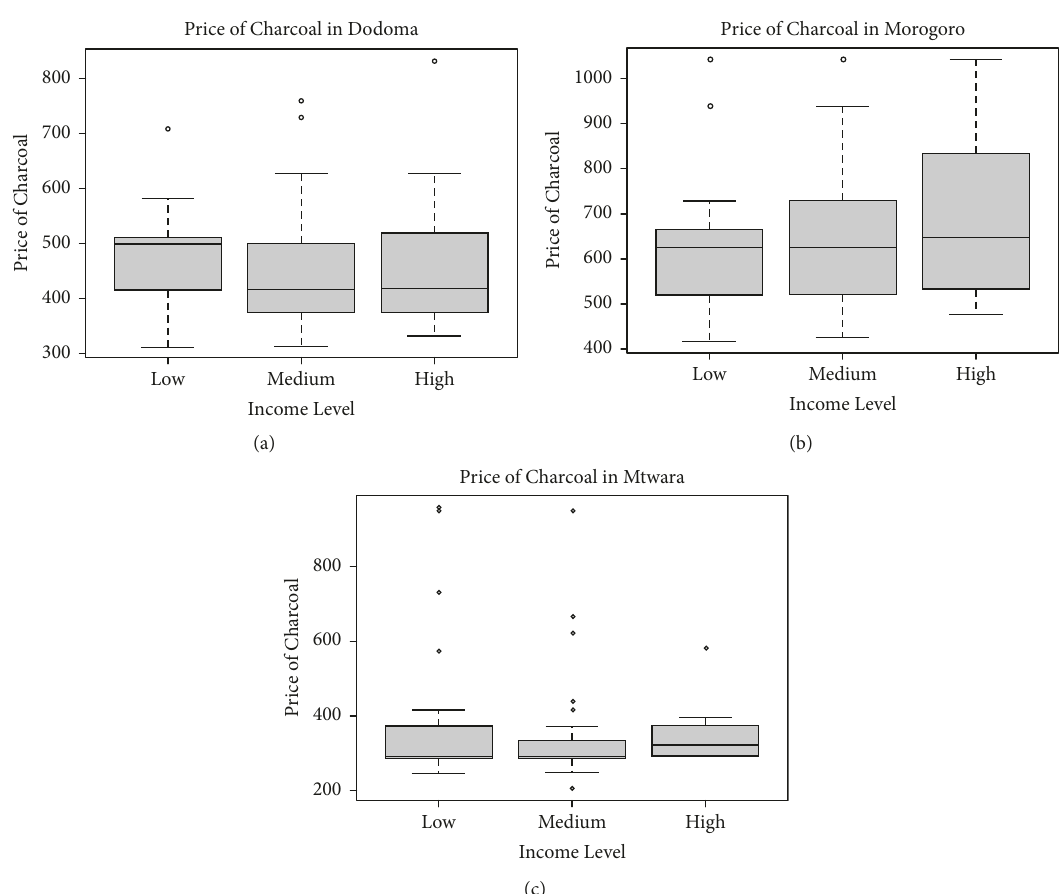
Figure 9: Price of charcoal (TZS per kg) for each income group in each